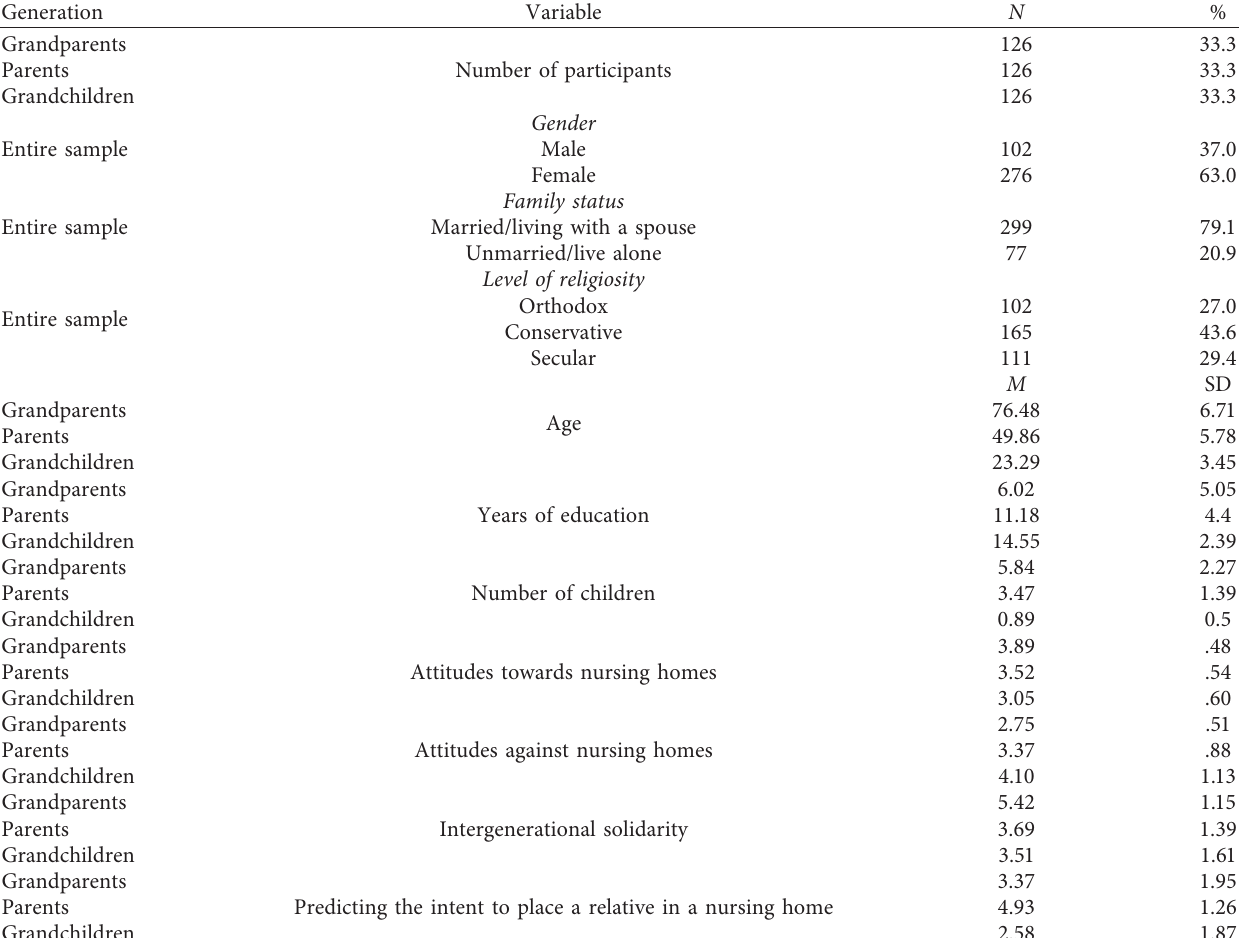
Table 1: Background characteristics ( N �